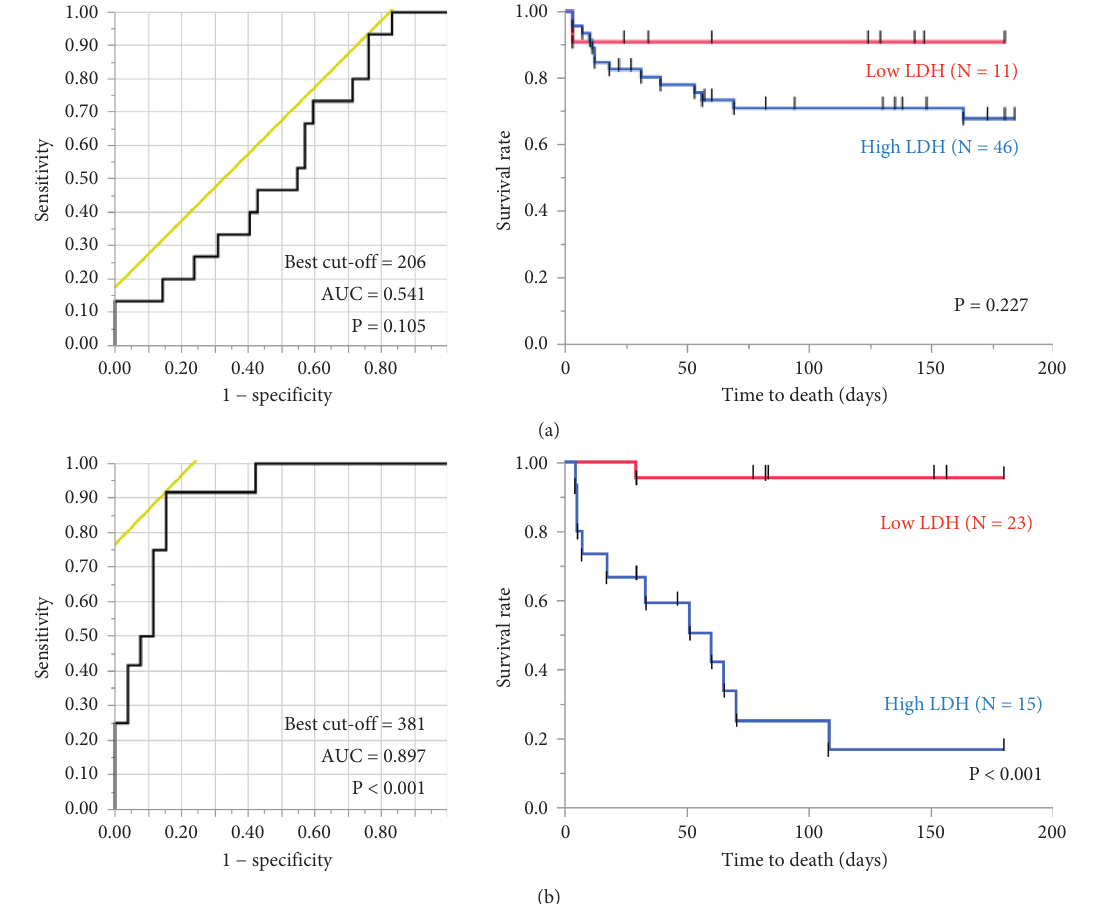
Figure 2: Relationship between 6-month mortality and serum LDH levels. In patients with low serum KL-6 levels, the AUC is 0.541 in the evaluation of serum LDH as a predictor of 6-month mortality (a). Log-rank tests show that the Kaplan–Meier survival curves of these groups do not differ significantly ( P � 0.227) (A). On the contrary, in the patients with high serum KL-6 levels, the AUC value is 0.897 in the evaluation of serum LDH as a predictor of 6-month mortality (b). Log-rank tests show that the Kaplan–Meier survival curves of these groups differ significantly ( P < 0.001) (B). AUC: area under the ROC curve; LDH: lactate dehydrogenase; KL-6: Krebs von den